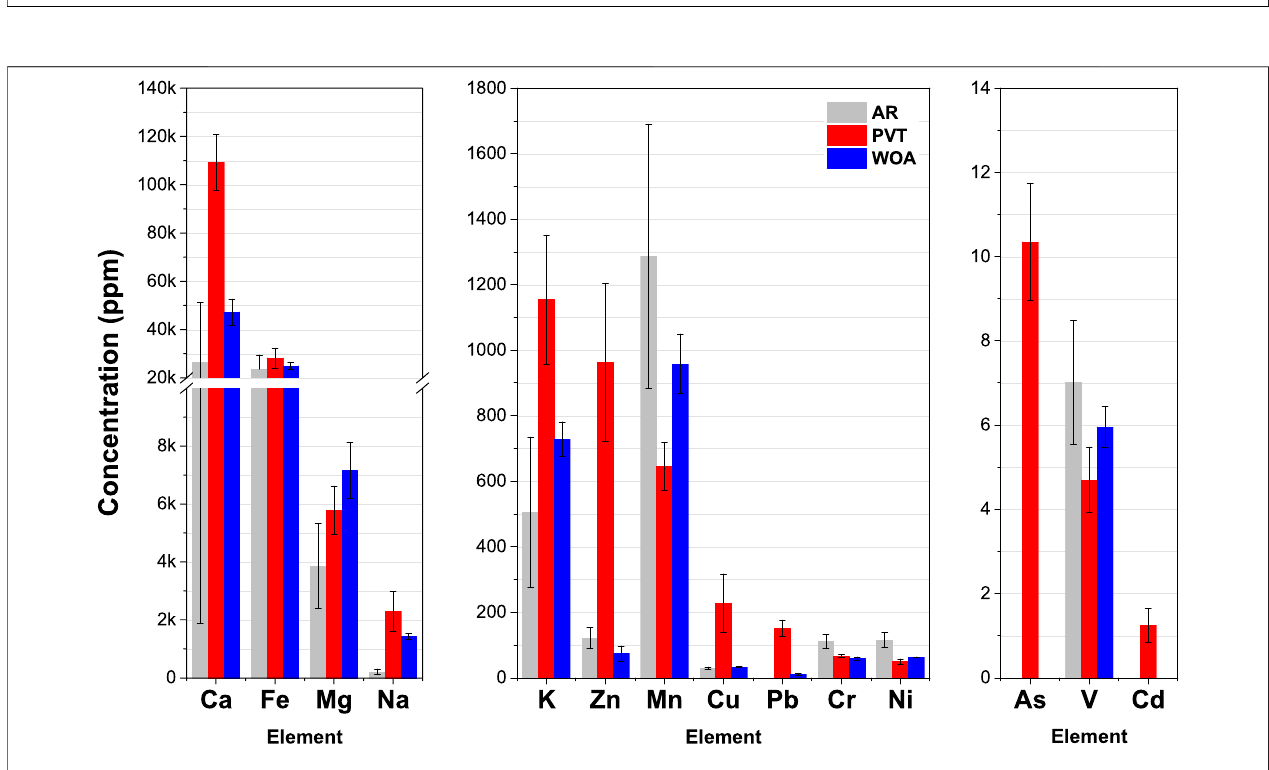
FIGURE 5 | Element concentrations in different soil